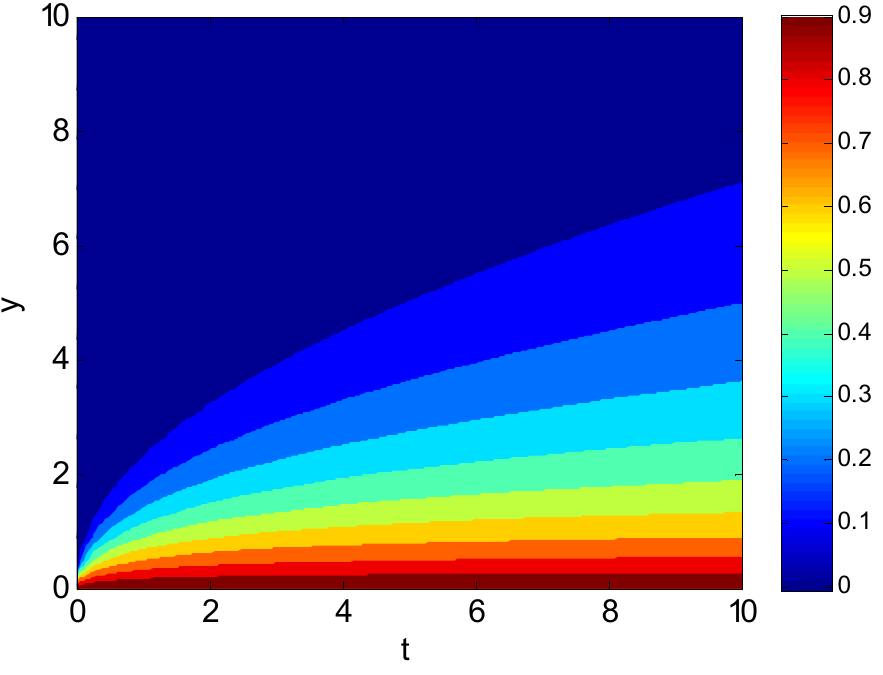
Figure 5. Contours of velocity profile.